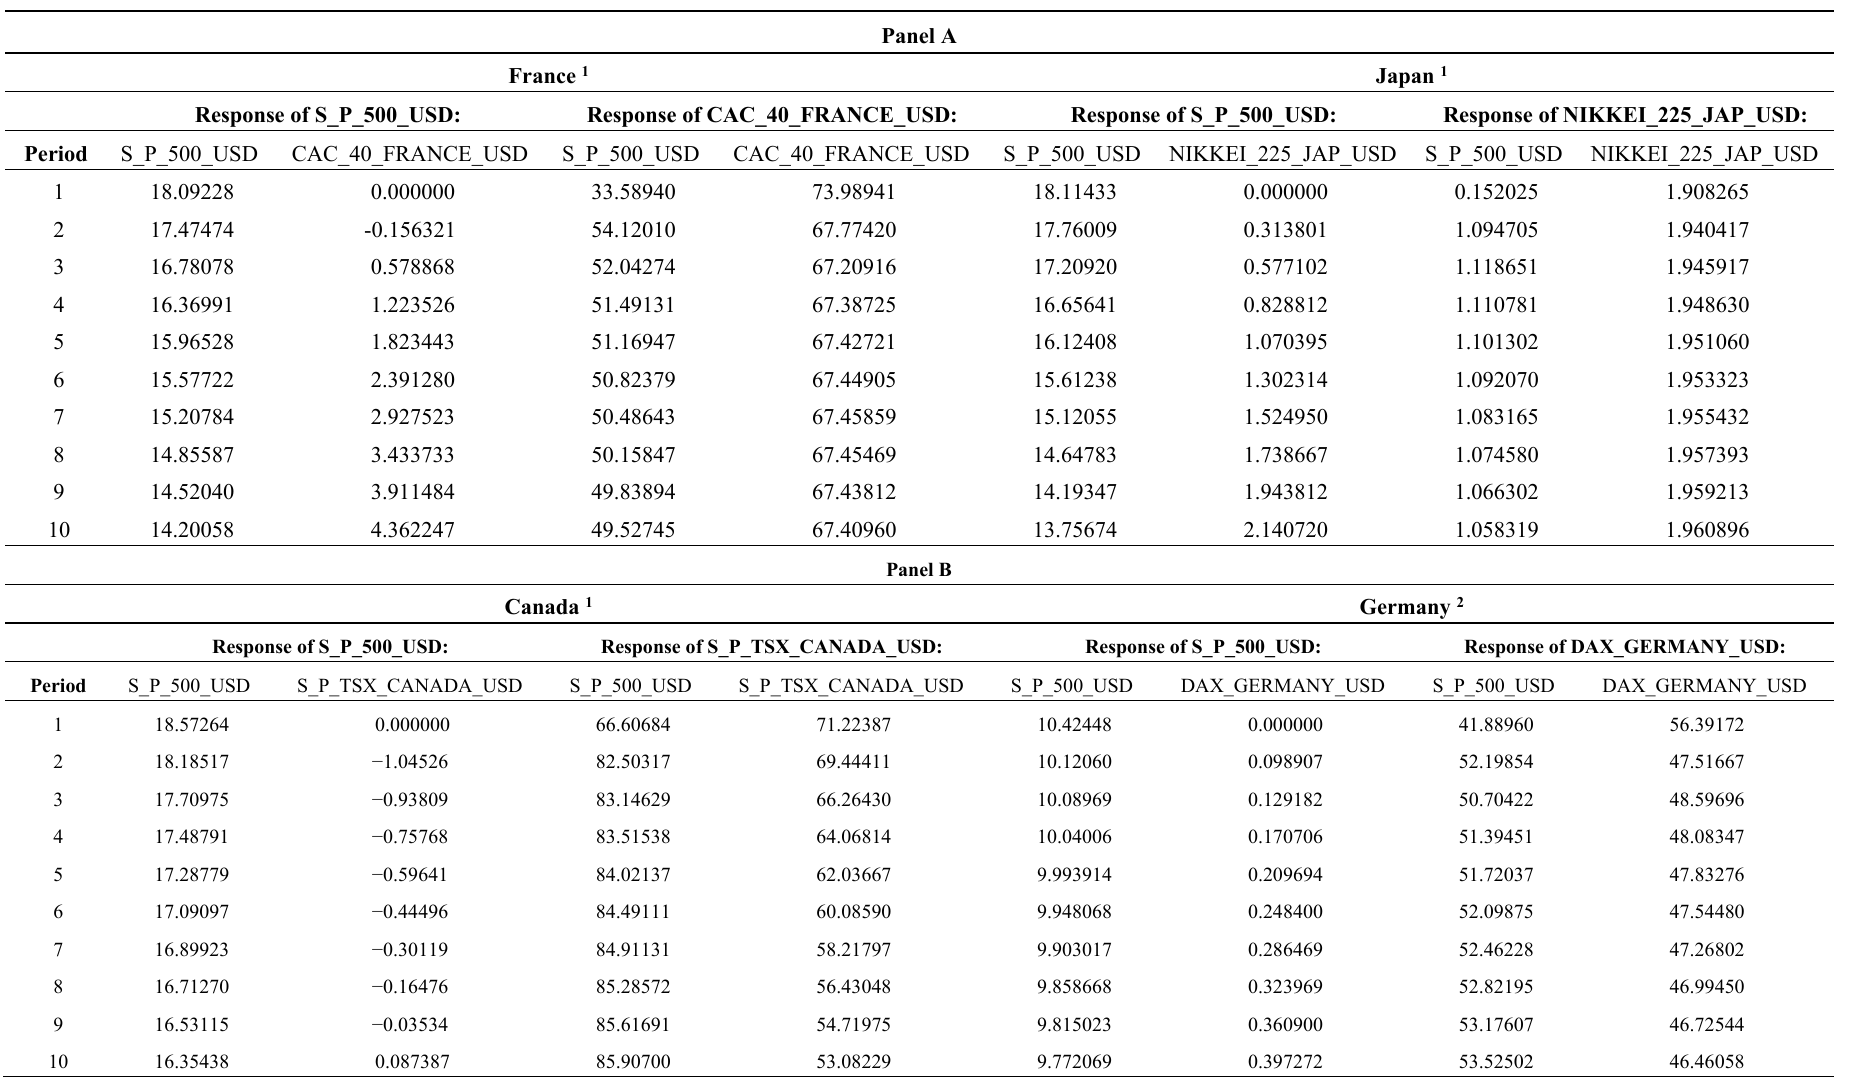
Table A5. Impulse Response